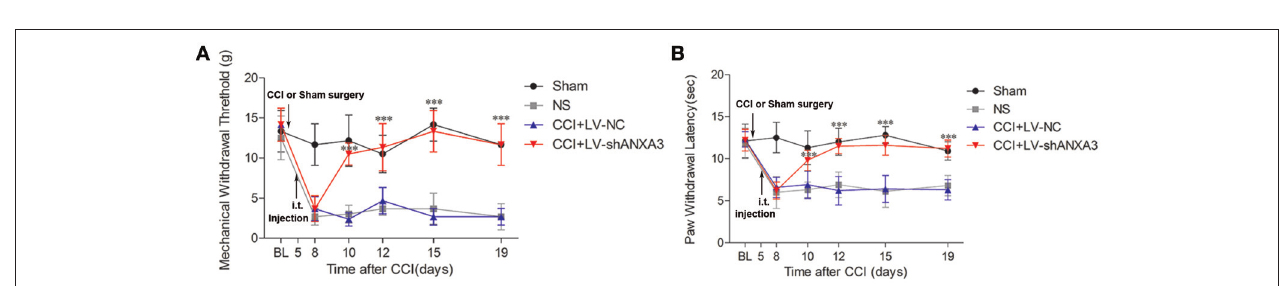
FIGURE 7 | Tactile allodynia and thermal hyperalgesia after CCI and intrathecal injection of LV vectors. Animals were either left un-operated (sham) or injected with saline (NS), ANXA3 shRNA negative control vectors (LV-NC), or LV-shANXA3 vectors (LV-shANXA3) for a total volume of 10 µ l, respectively. Only animals that demonstrated tactile allodynia and thermal hyperalgesia 5 days after CCI were injected with the vectors. (A) PMWT and (B) PWTL were measured 1 day before CCI (BL, baseline) and 8, 10, 12, 15, and 19 days after CCI or 3, 5, 7, 10, and 14 days after intrathecal delivery. “BL” is the time point of the basic pain threshold before CCI in rats, “8” is the time point 8 days after CCI (3 days after intrathecal delivery). Data are expressed as mean ± SD , n = 8, Significance is defined as * P < 0.05, *** P < 0.001 compared with LV-NC at each time point by one-way ANOVA followed by Bonferroni test.